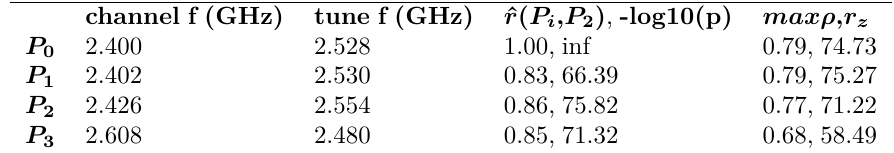
Table 3: Similarity among profiles (ˆ r ( P i ,P 2 )) and strength of the leak ( maxρ,r z ) for different channel frequencies (and the corresponding frequency at which we tune). Profiles are similar, showing that the distortion of screaming-channel leaks is constant with frequency. The same applies for the amount of